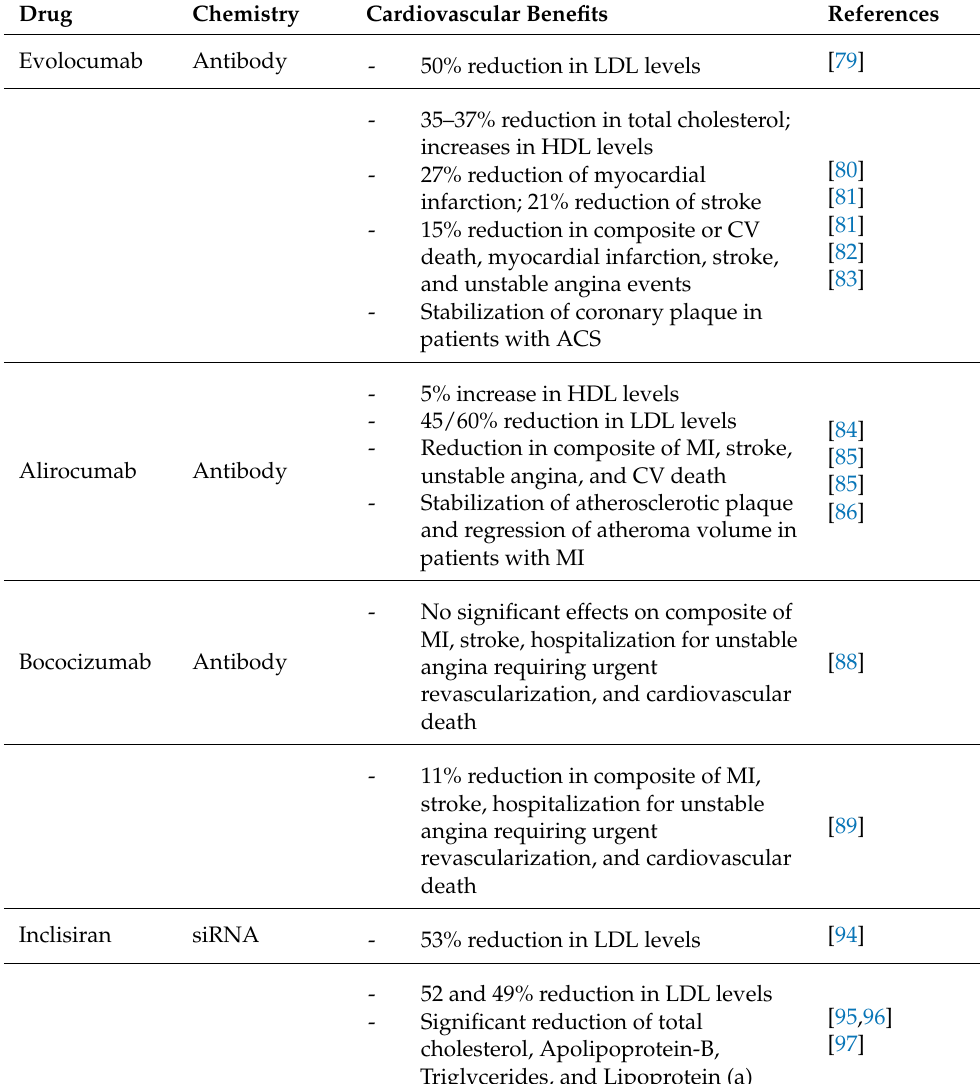
Table 1. Main cardiovascular benefits derived from PCSK9i therapies in randomized controlled